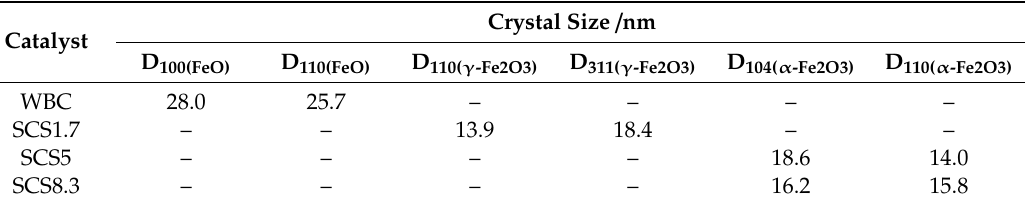
Table 1. Crystal size of fresh catalysts.